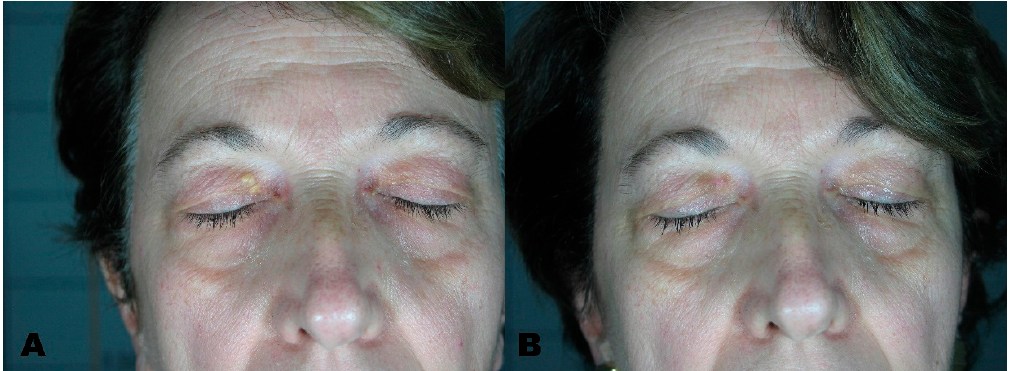
Figure 4. ( A ) Xhantelasmas before treatment. ( B ) Region after removal with Erbium laser.